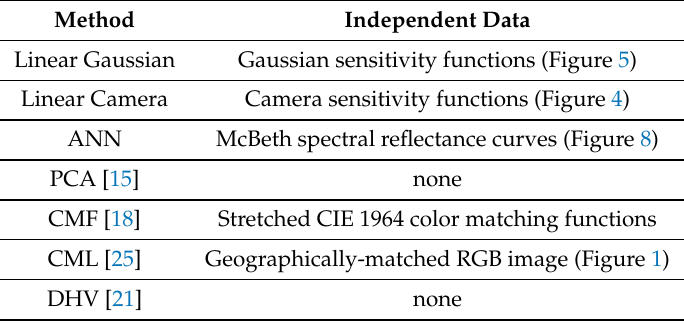
Table 3. Independent data used by the methods under